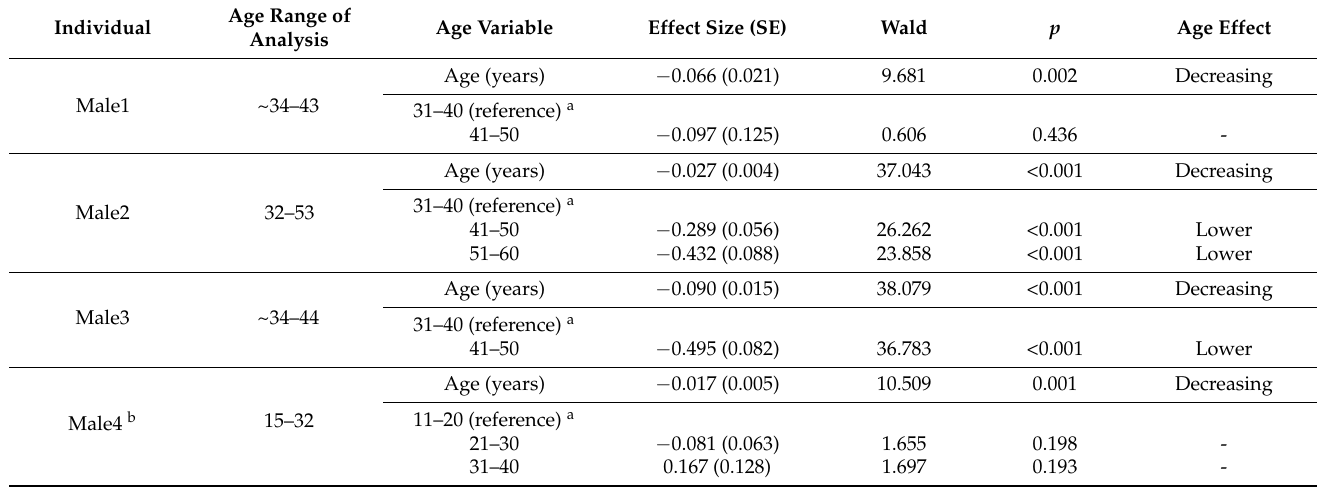
Table 8. Age as a predictor of testosterone. Individual, age range of analysis, age variable (age, age category), effect size with standard error (SE), Wald statistic, and p -value from GLMMs; and relative effect of age on mean testosterone concentrations. Degrees of freedom (df) is 1 in all pair-wise comparisons.